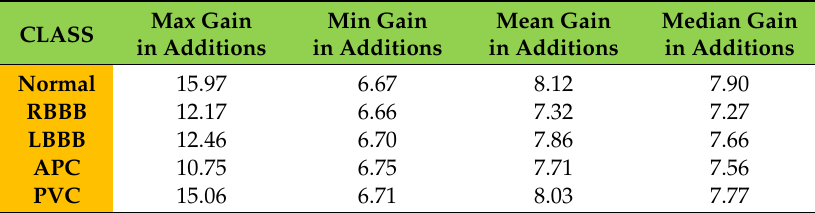
Table 4. Summary of the ARFIR computational gains, in multiplications, over the classical FIR filtering.